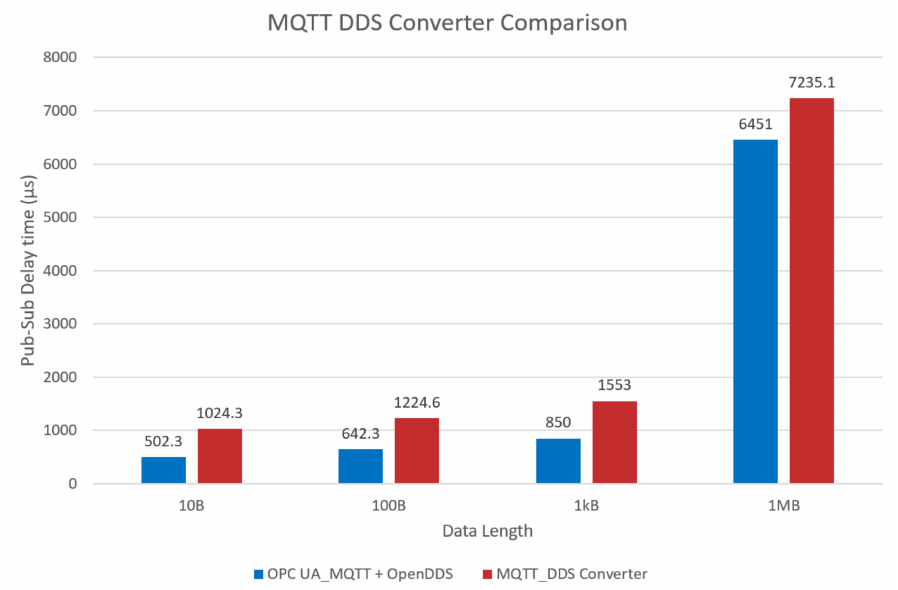
Figure 17. Comparison of latencies with and without the MQTT-based